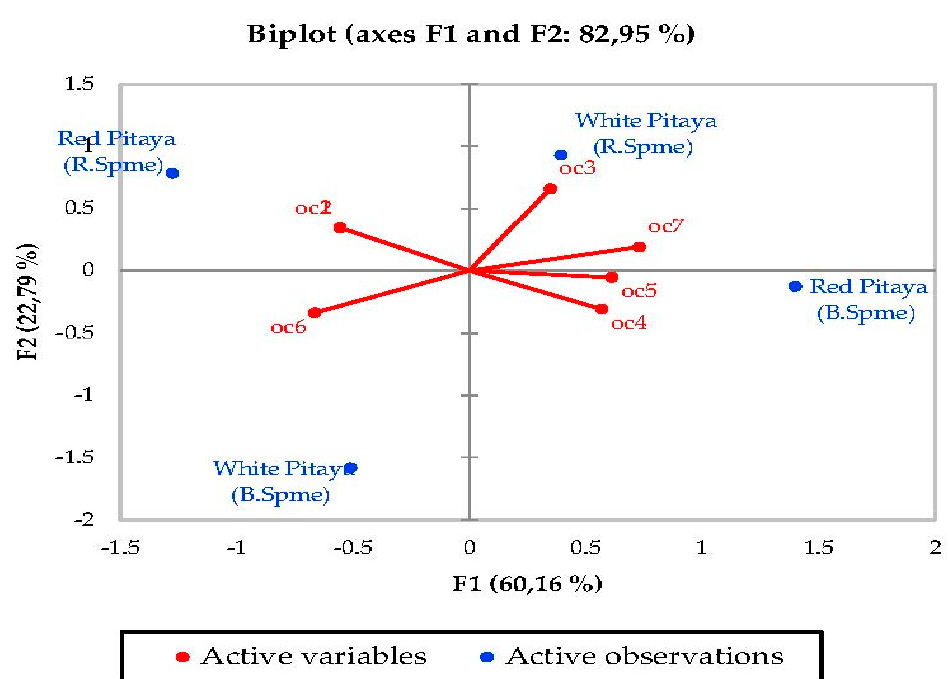
Figure 8. Biplot graph (scores and loading plots) obtained from Principal Component Analysis for other compounds from volatile compounds in red-white pitaya. oc1: methyl isocyanide, oc2: 1-methyl->Piperidine, oc3: 2,6-bis(1,1-dimethylethyl)-4-methyl- Phenol, oc4: 1,1 ′ -oxybis- Octane, oc5: 2,6,10,14-tetramethyl- Hexadecane, oc6: tetranitro- Methane, oc7: Tridecane. Other compounds, PC1 explained 60.16% of the total variance, PC2 explained